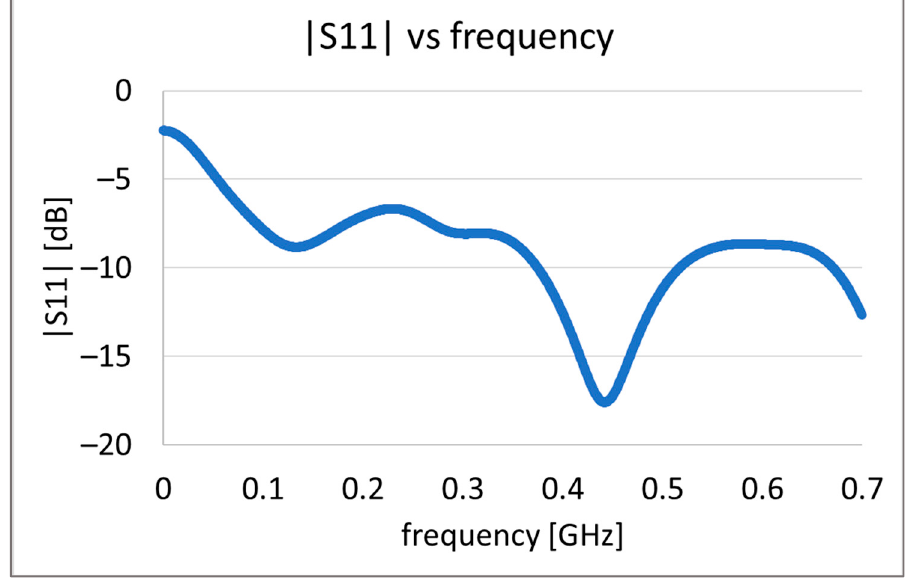
Figure 5. Impedance matching of the proposed conformal antenna presented on Figure 3.